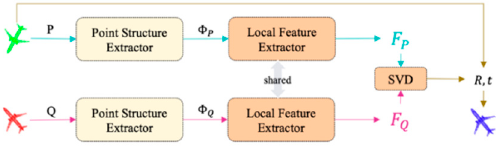
Figure 15. Algorithm model structure.